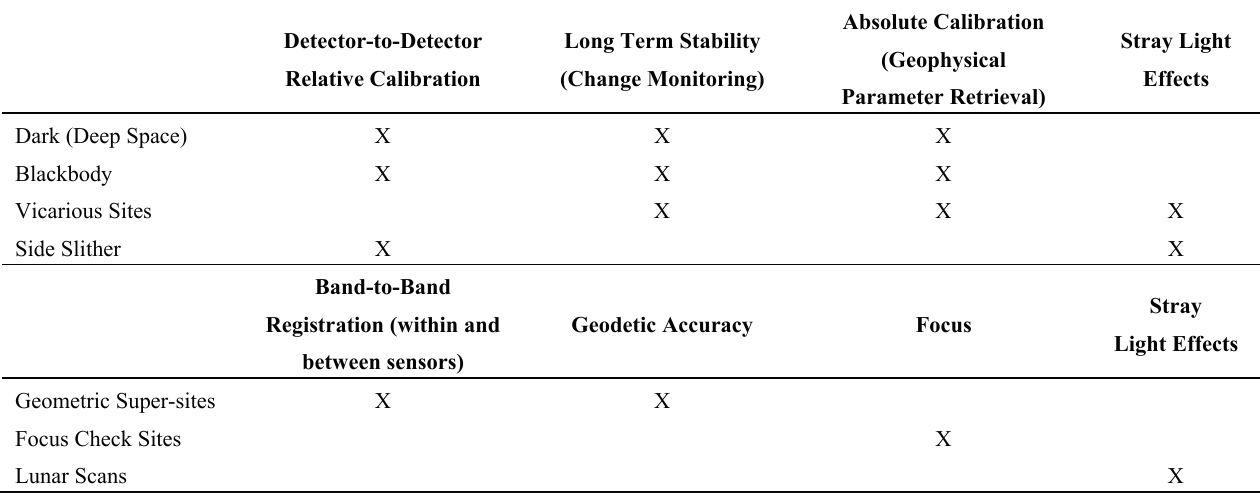
Table 2. TIRS on-orbit calibration data types and their